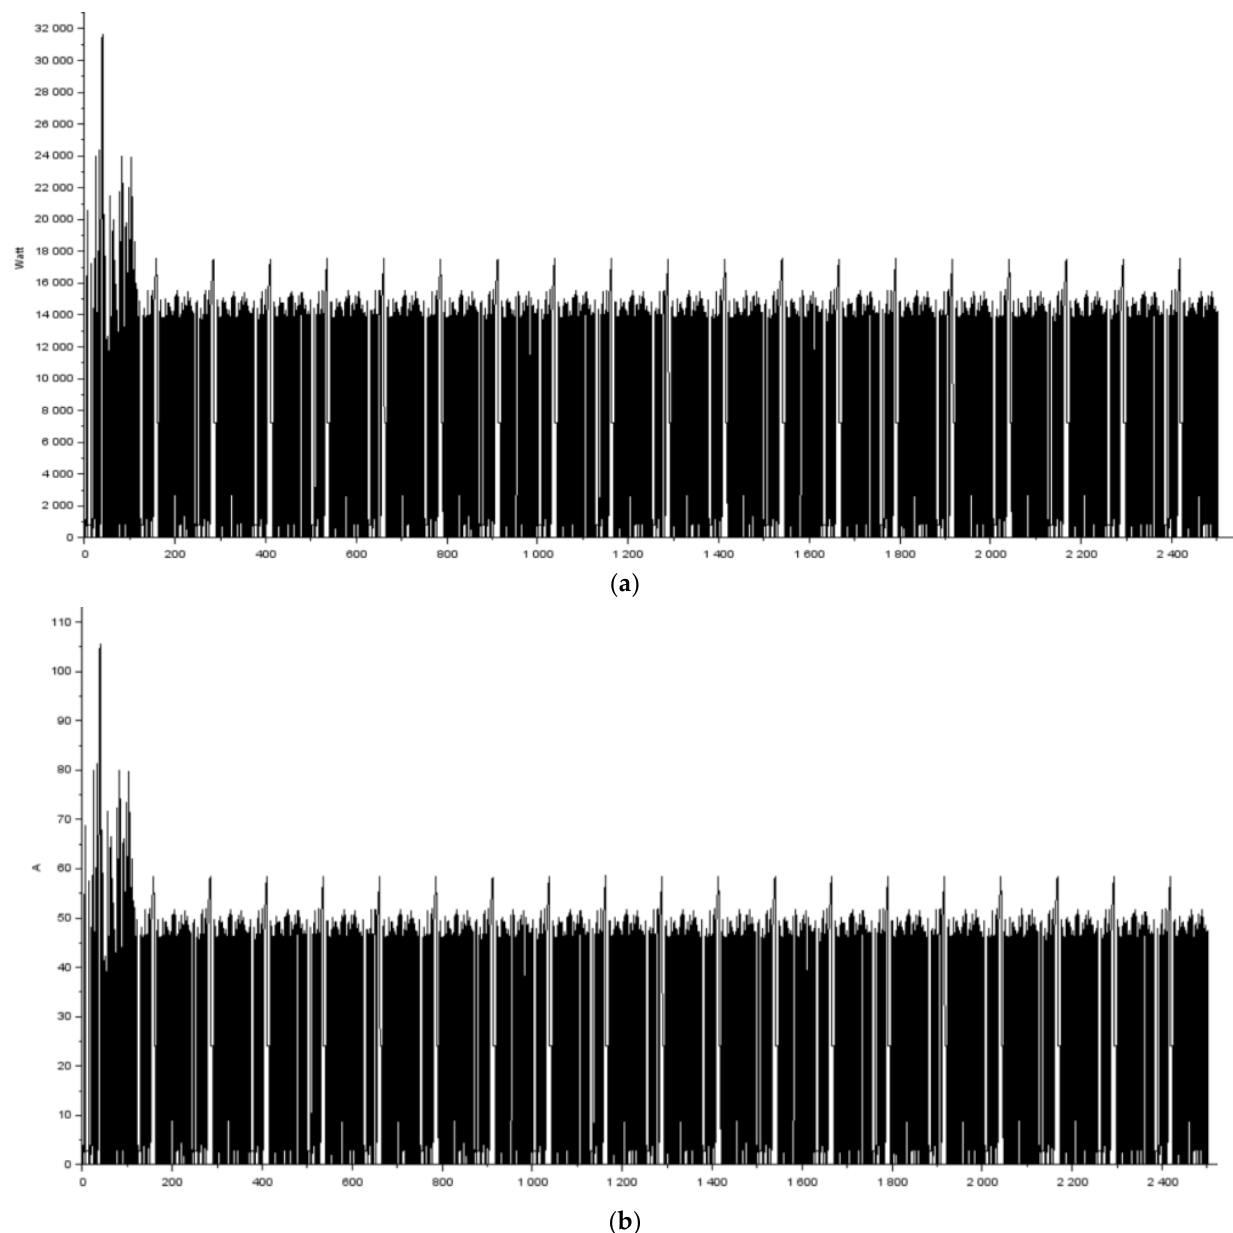
Figure 8. ( a ) Battery power and ( b ) battery current.